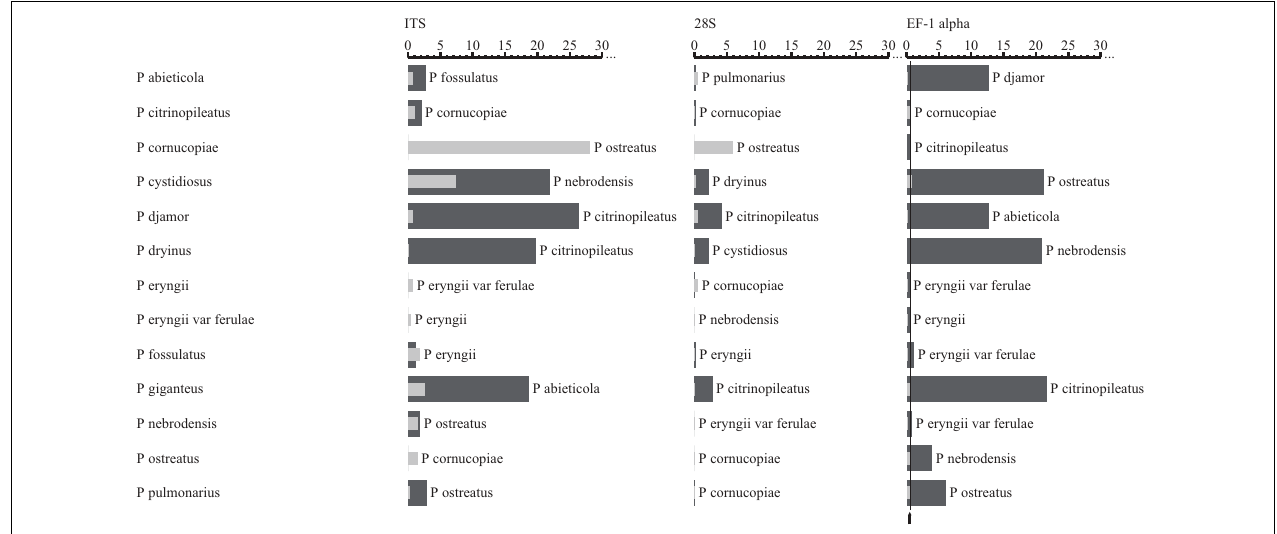
FIGURE 1 | Comparisons of intra- and interspecific variations among the ITS, 28S rDNA, and EF-1 α gene from the Pleurotus species tested. The gray and black bars represent the intra- and interspecific variations, respectively. The thin black lines indicate the smallest interspecific variation. The names next to the dark bars indicate the closest